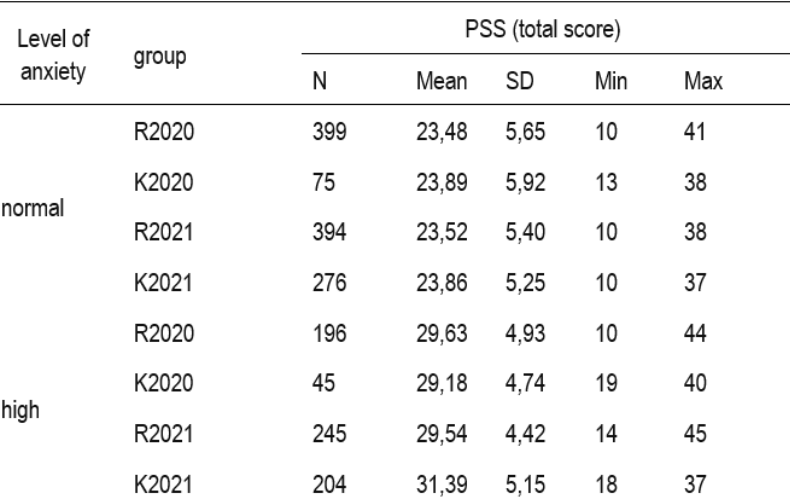
Perceived stress levels in schoolchildren with normal and high anxiety levels